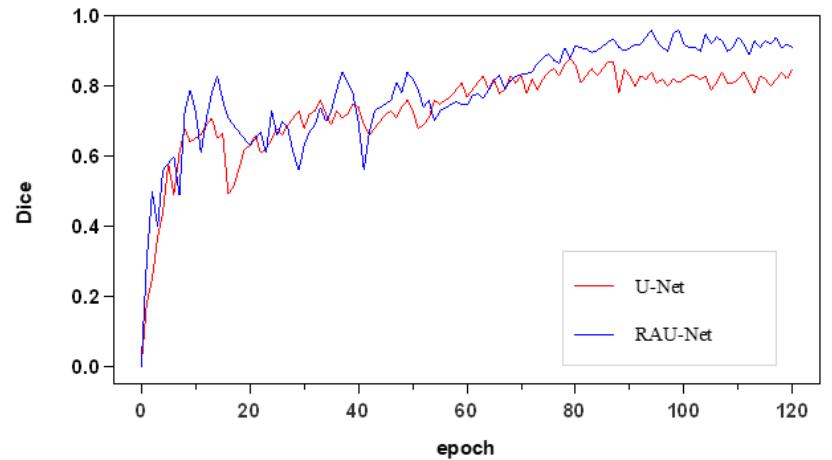
Figure 7. Dice coefficient variation of two networks in the validation set.